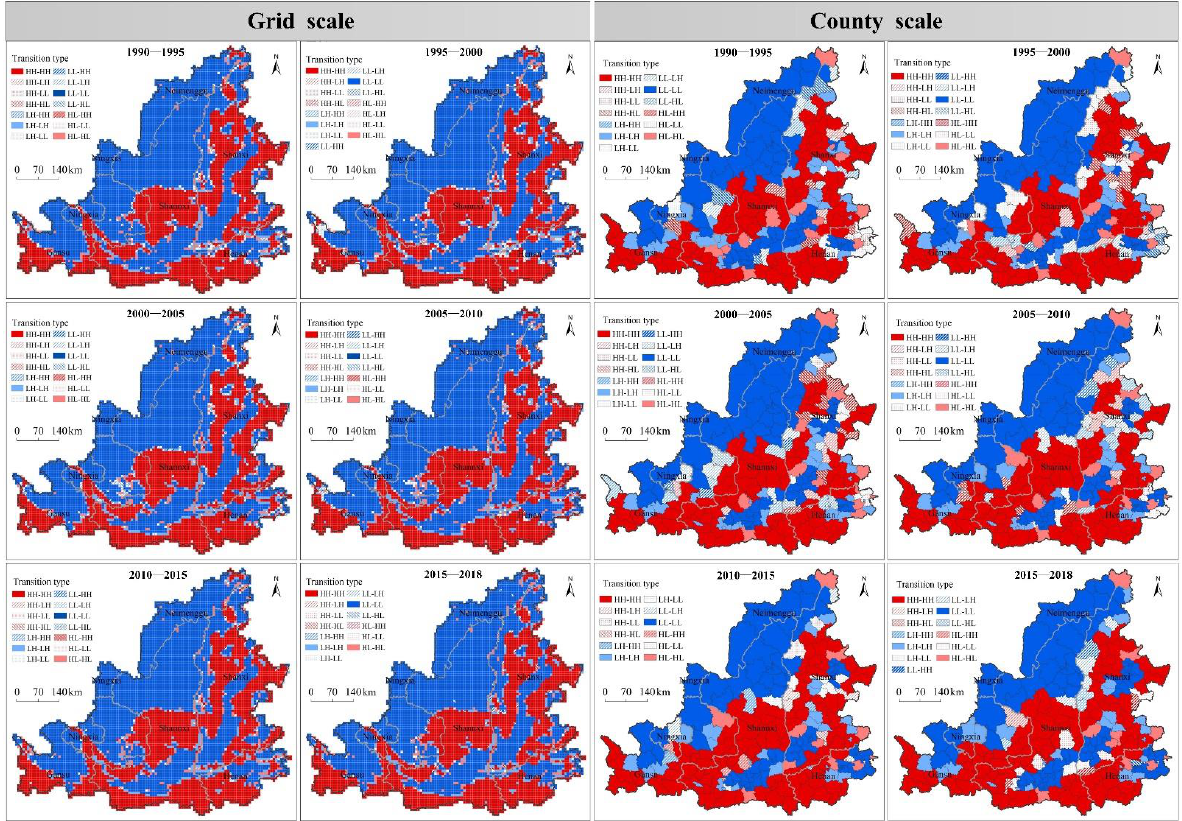
Figure 8. Ecosystem health Local Moran’s I spatial transition map at grid and county scale.